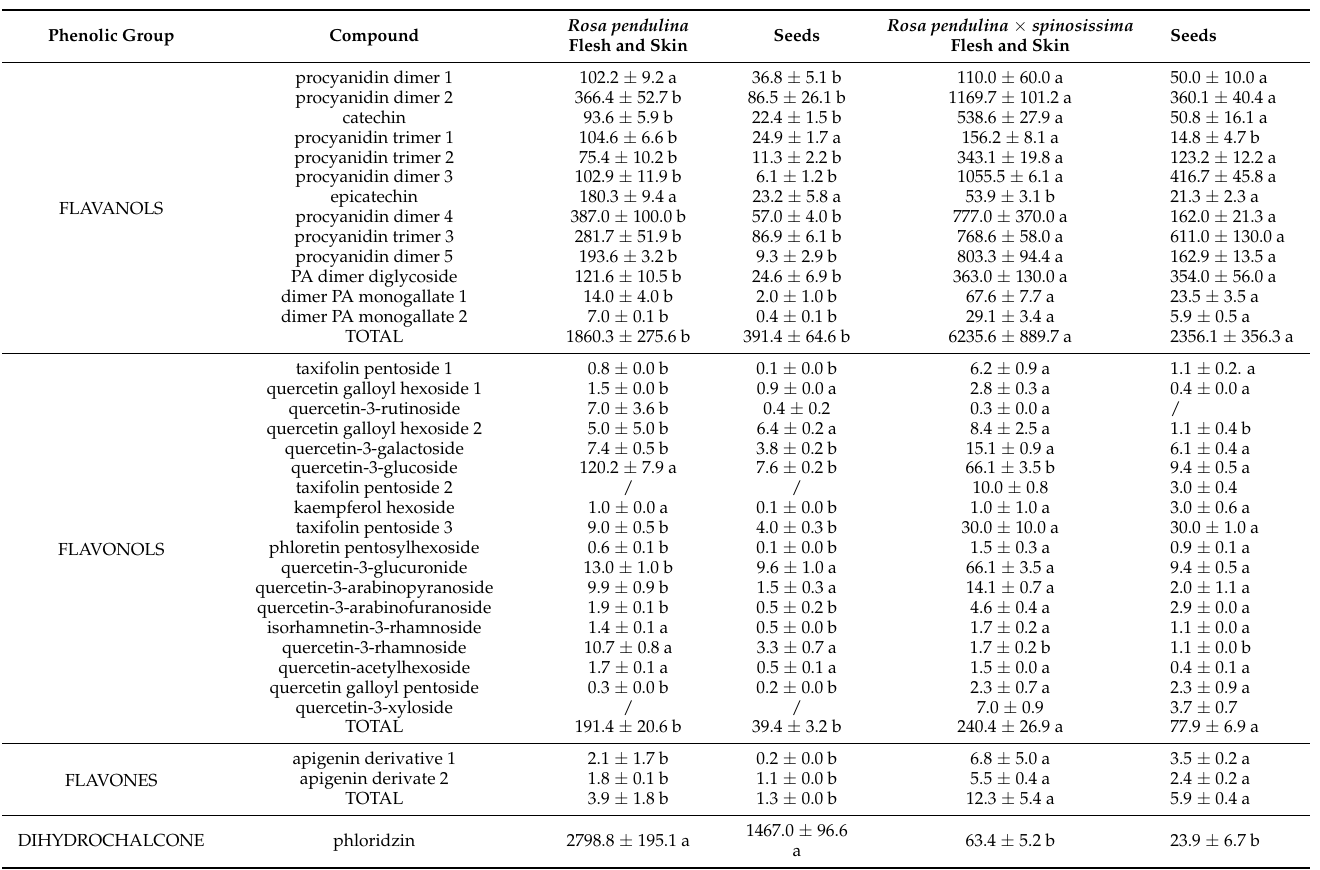
Table 3. Contents ± standard deviations (mg/kg FW) of phenolic compounds in hips of R. pendulina and the hybrid R. pendulina × spinosissima in the region of Western Slovenia in 2020. Different letters indicate statistical differences between the two genotypes, separately for flesh with skin and